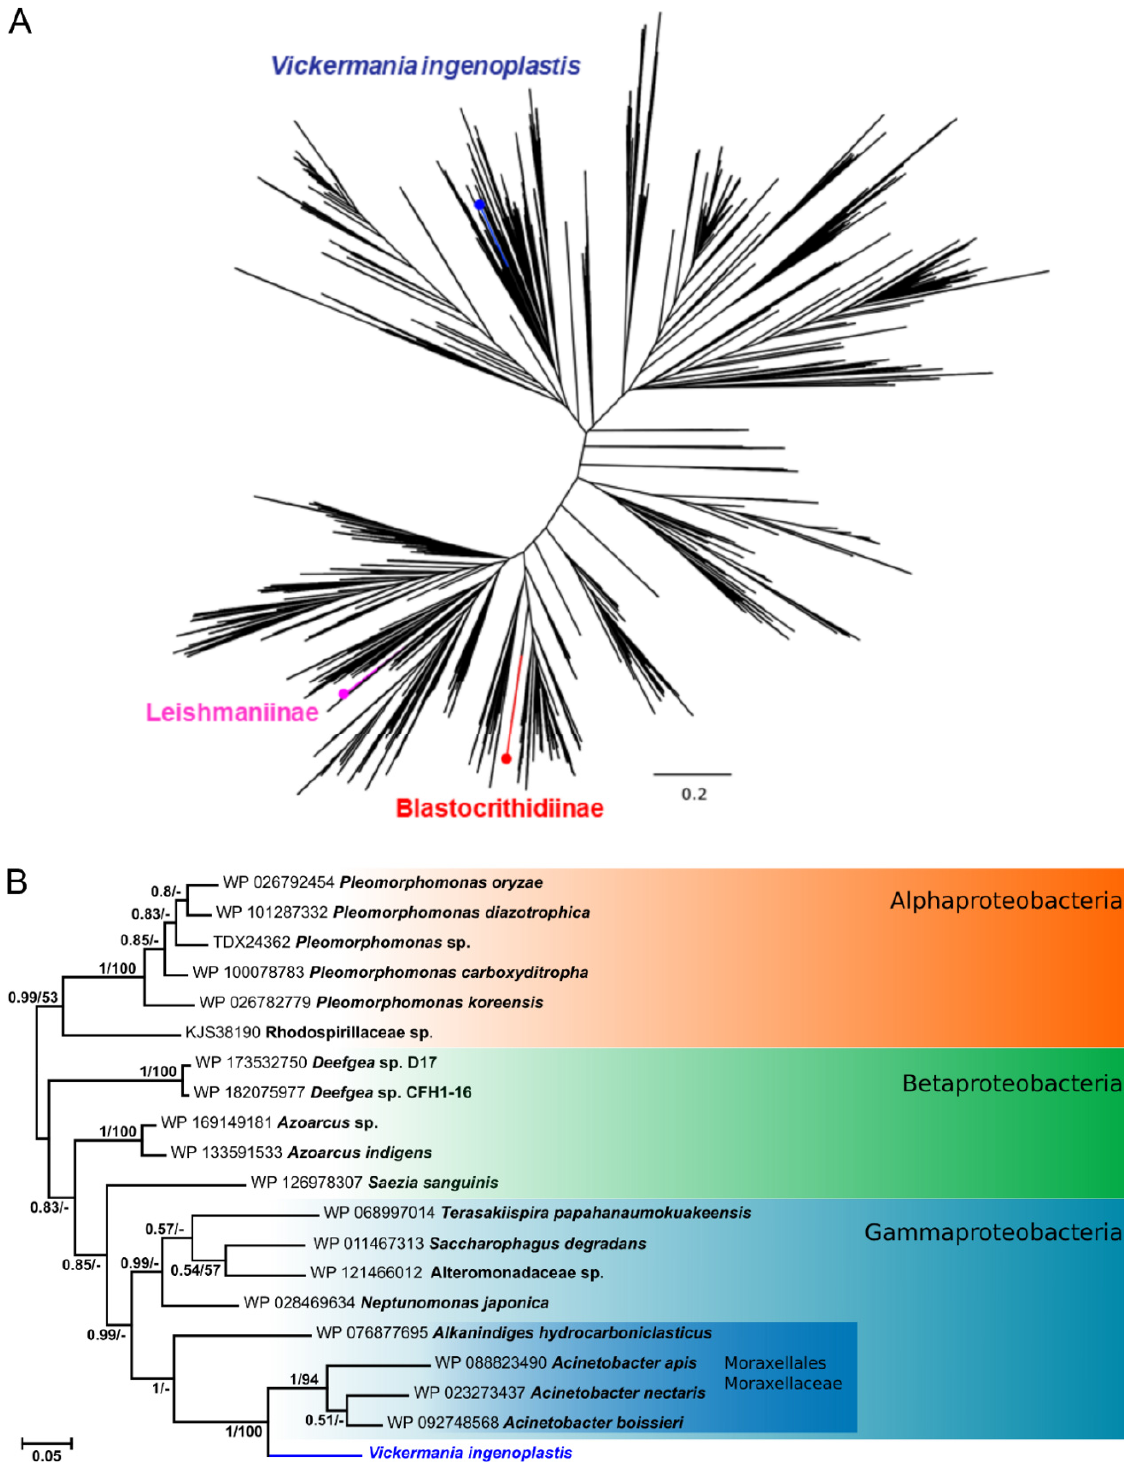
Figure 1. Origin of catalases in trypanosomatids. ( A ) Phylogenetic tree showing the position of trypanosomatid enzymes. ( B ) Phylogenetic tree of the closest relatives of the catalase in V. ingenoplastis . Numbers indicate Bayesian posterior probability and bootstrap supports, respectively. Bacterial taxonomy (classes for all, order, and family for the closest relatives of V. ingenoplastis ) is on the right. Scale bars in ( A , B ) indicate the number of substitutions per site.